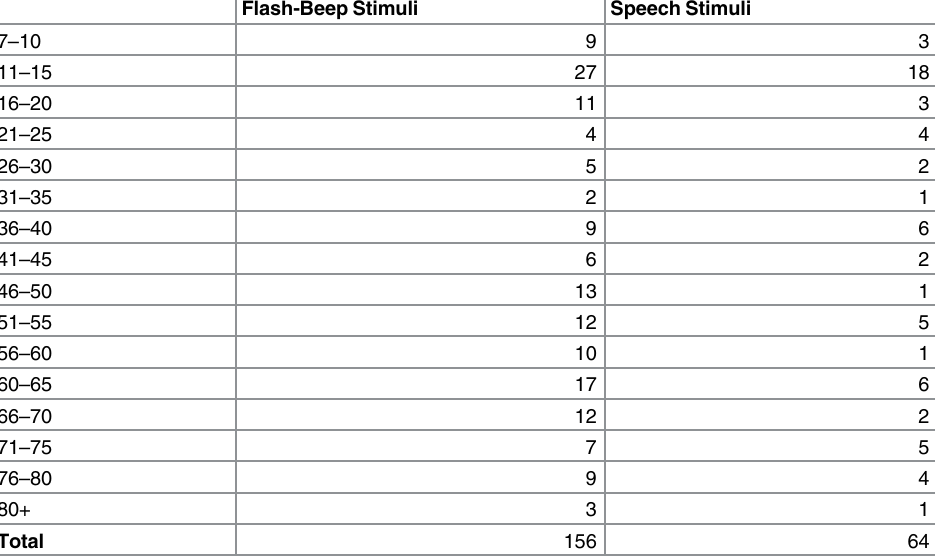
Table 1. Number of participants as a function of age and stimuli presented. Number of participants within given age (left column) bins for both the Flash-Beep stimuli (middle column) and Speech stimuli (right column).